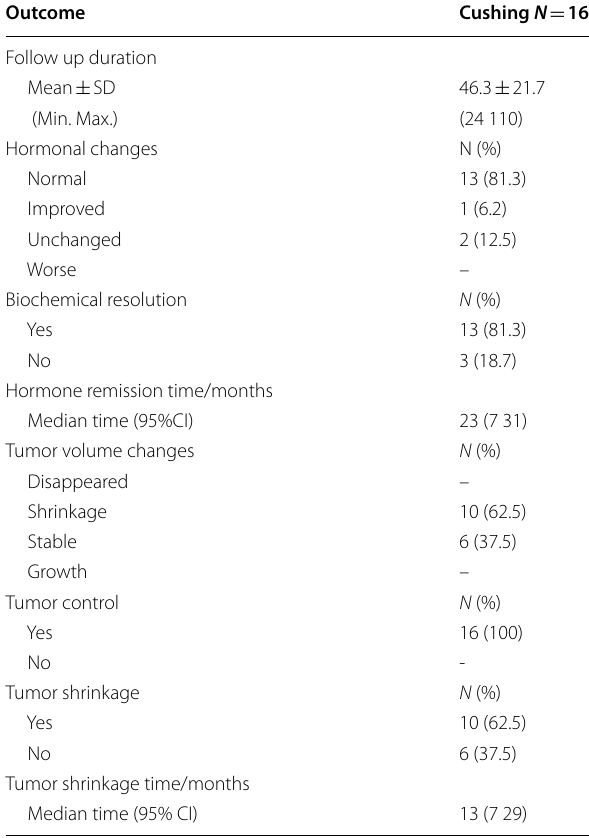
Table 4 Tumor volume and biochemical control